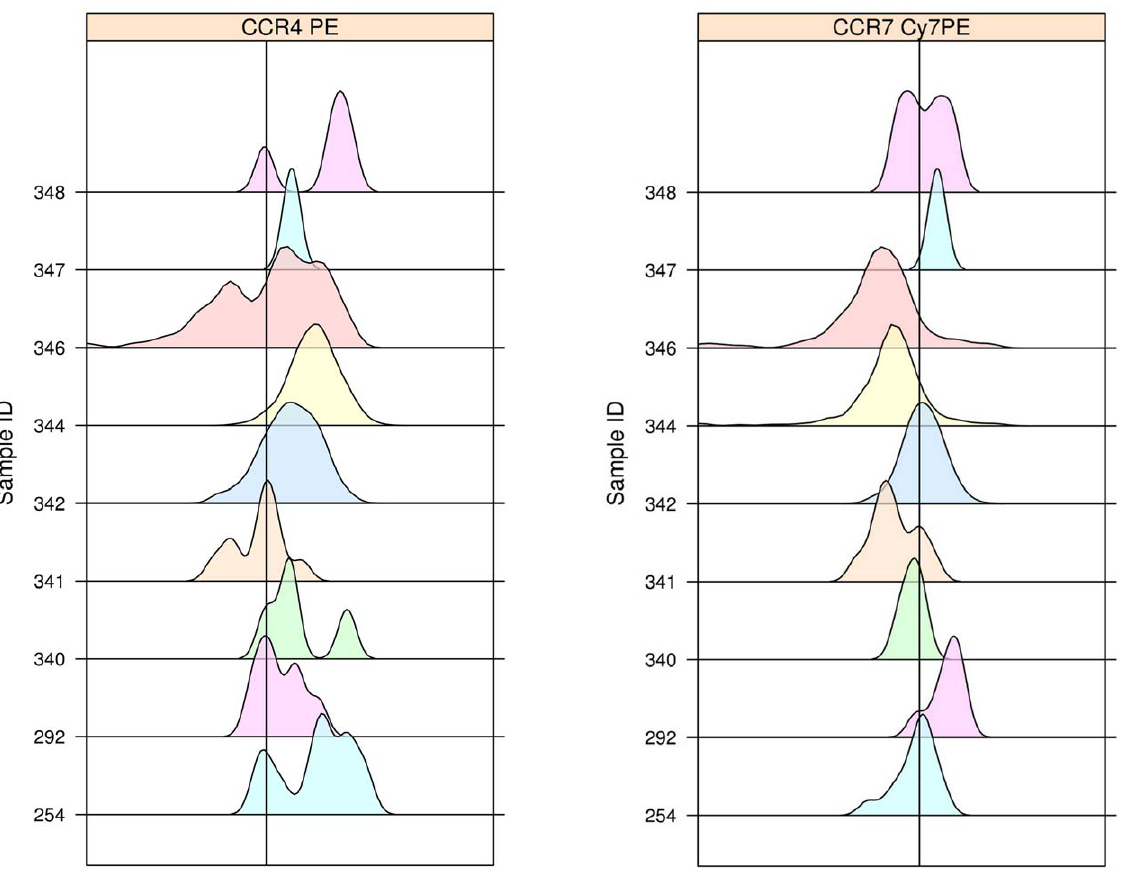
Figure 5. Density plots of chemokine receptor expression by Treg. Representative density plots of CCR4 and CCR7 expression by BALF Treg. The parent populations for determination of chemokine receptor positivity were singlet, live, CD3 + CD4 + CD25 hi Foxp3 + lymphocytes as shown in Figure 1. (left) Demonstrates the generally high level of CCR4 expression by Treg. The CCR4 gate was determined such that , 0.1% of the cells were positive in the CCR4 FMO tube (see text for detail). (right) Demonstrates the variability of CCR7 expression by Treg. The CCR7 gate was determined such that , 0.3% of the cells were positive in the CCR7 FMO tube.